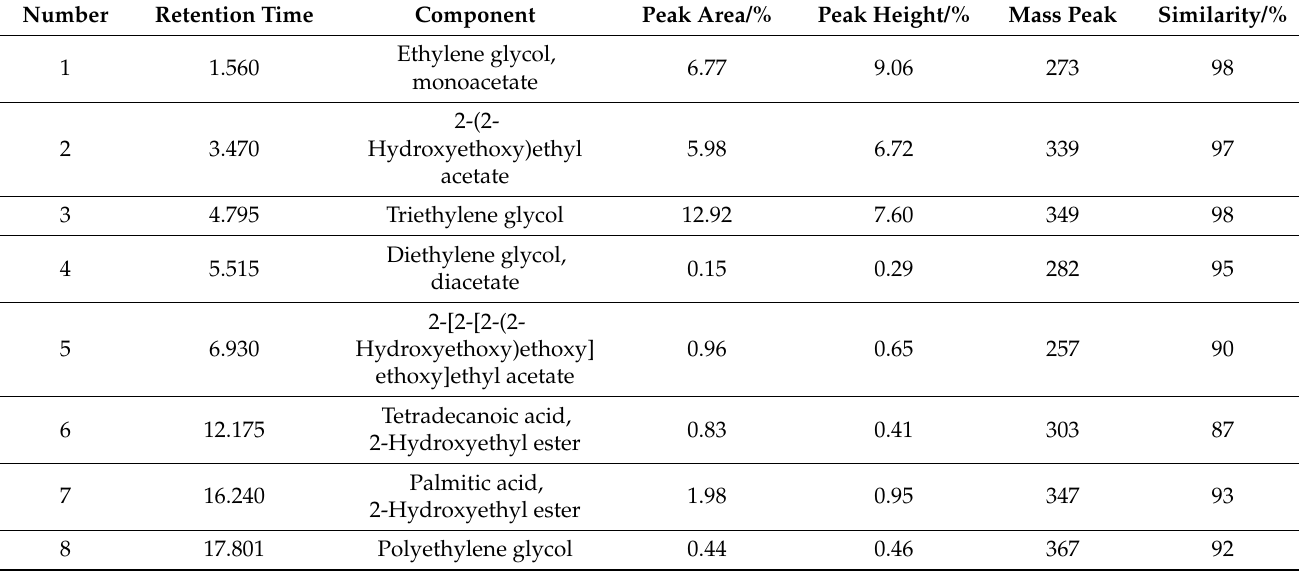
Table 5. Analysis of methanol extract for untreated sample 4.